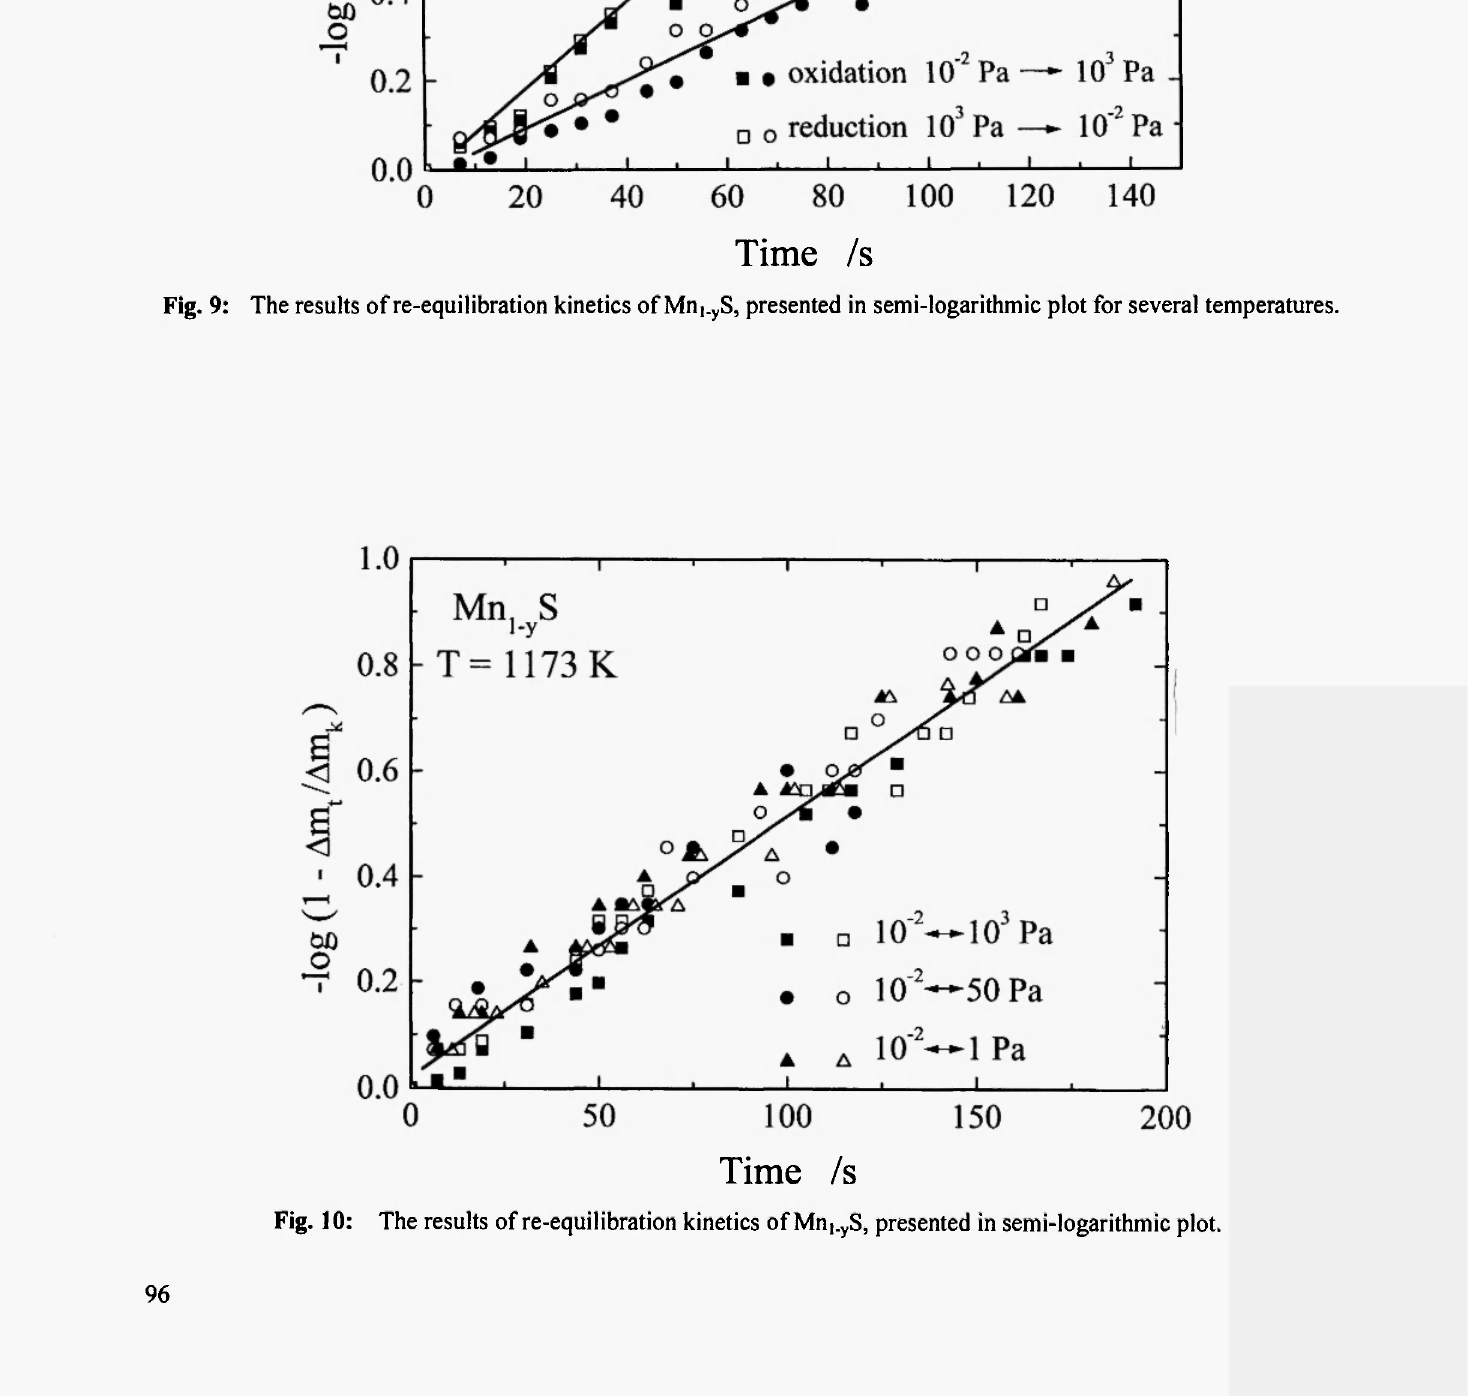
Fig. 10: The results of re-equilibration kinetics of Mn^S, presented in semi-logarithmic